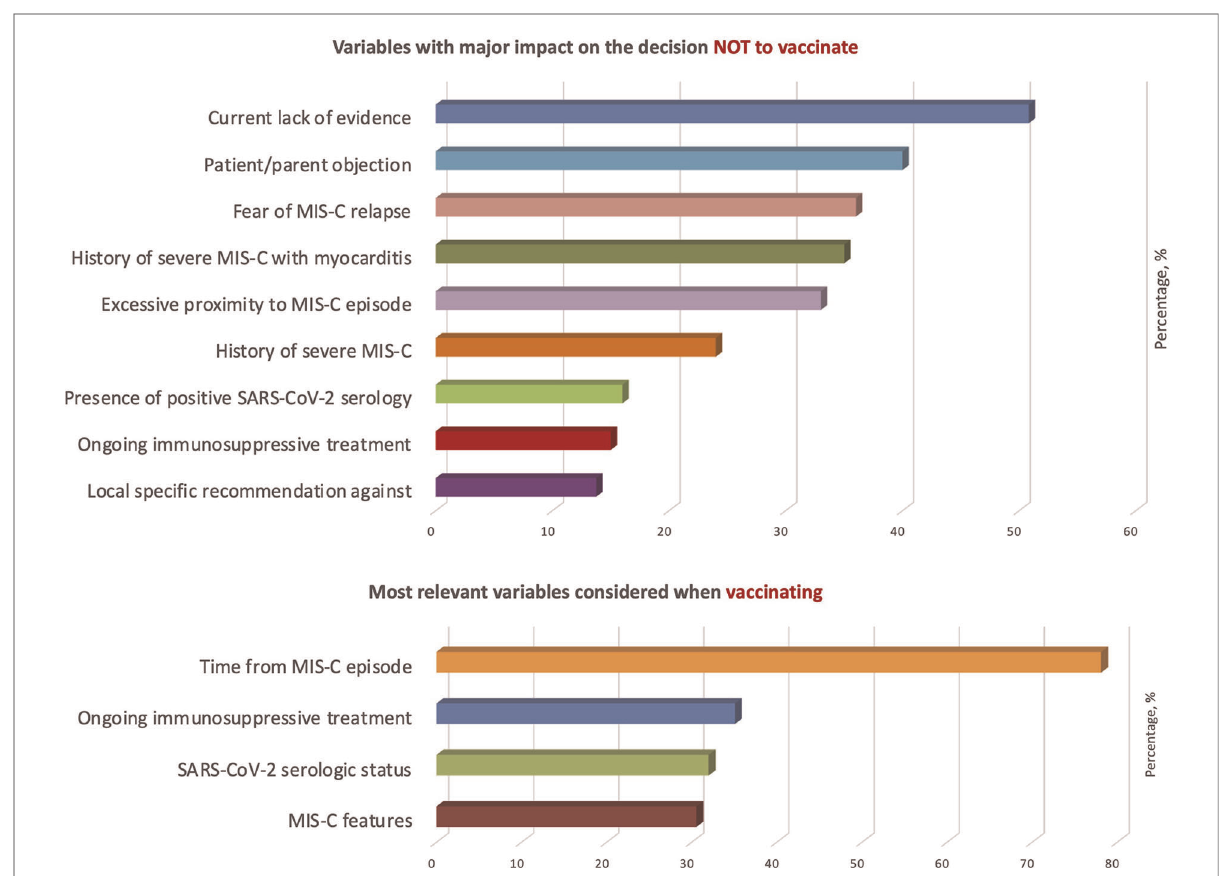
FIGURE 3 Variables with a major impact in the vaccination strategy against SARS-CoV-2 in patients with a history of